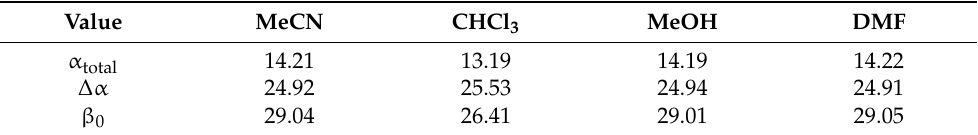
Table 7. The α total , ∆ α , and β 0 parameters for compound 2 as a multiple of the values for urea (i.e., value 2 /value (urea)).